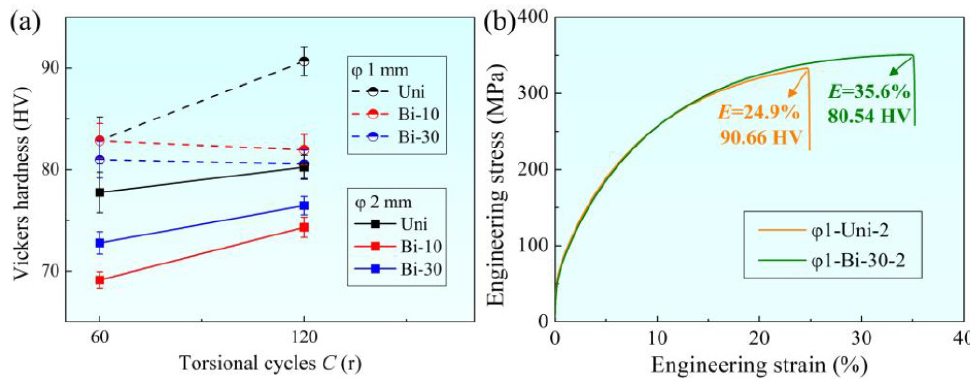
Figure 6. ( a ) Variations of Vickers hardness with torsional cycles. ( b ) The strain − stress curves of samples φ 1-Uni-2 and φ 1-Bi-30-2.